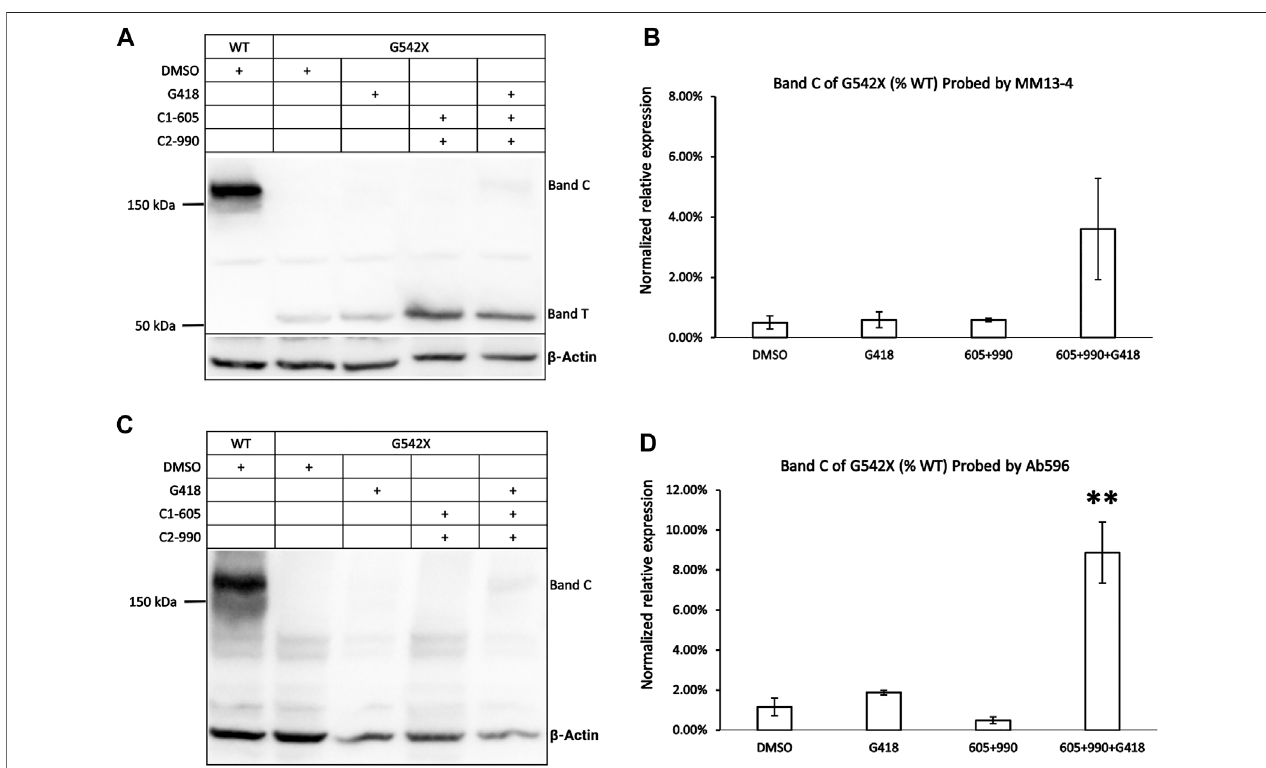
FIGURE1| WesternblotanalysisofG542X-CFTRusingtwodifferentantibodies. (A) EffectsofCFTRtype1corrector605,type2corrector990,andread-through reagentG418onG542X-CFTRexpression.ThegelwasprobedwithCFTRN-terminalantibodyMM13-4. (B) Quanti fi cationoftheexpressionofbandCofG542X-CFTR compared to WT-CFTR with MM13-4 (N = 3). (C) Western blot of G542X-CFTR similar to panel A except that the gel was probed with antibody 596 which recognizes CFTR ’ sNBD2. (D) Quanti fi cationoftheexpression ofbandCinG542X-CFTRcomparedtoWT-CFTRbyAb596(N=4).Alldataarerepresentedasmean±SEM. The asterisks indicate that the level of band C in G542X-CFTR is signi fi cantly higher than that of control in DMSO (ANOVA followed by Dunnett ’ s test). ** p <